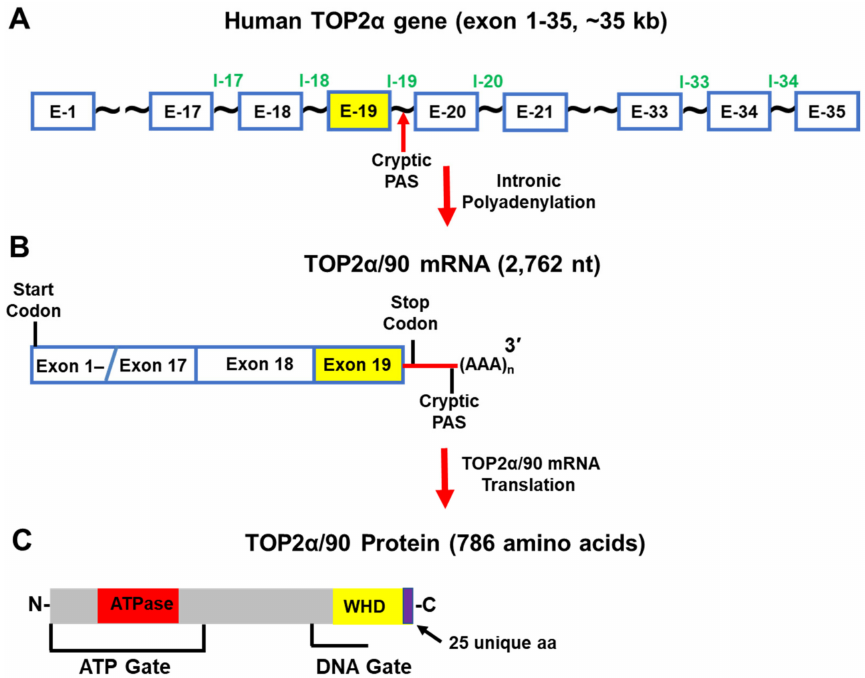
Figure 7. Schematic representation of the human TOP2 α gene, TOP2 α /90 mRNA, and TOP2 α /90 protein. ( A ) The human TOP2 α gene comprises 35 exons and spans ~35 kb. ( B ) When Intron 19 IPA occurs, the predominate TOP2 α mRNA transcript is 2762 nucleotides long. ( C ) This mRNA transcript encodes a TOP2 α isoform of 786 aa, denoted TOP2 α /90. The truncated TOP2 α isoform is missing the entire C-terminus (770 aa) present in TOP2 α /170 and lacks the active site Tyr805. The TOP2 α /90 isoform cannot form DNA covalent cleavage complexes and drug resistance occurs due to decreased drug-induced DNA damage, and